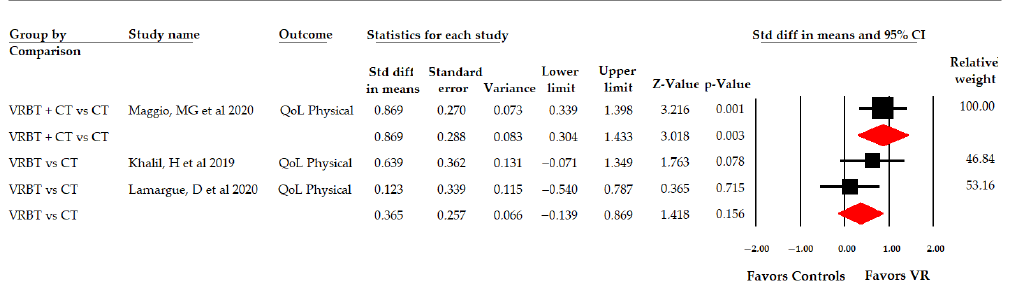
Figure 8. Subgroup Analysis of the Effect of Virtual Reality on the Physical Dimension of Quality of Life, According Specific Comparisons.